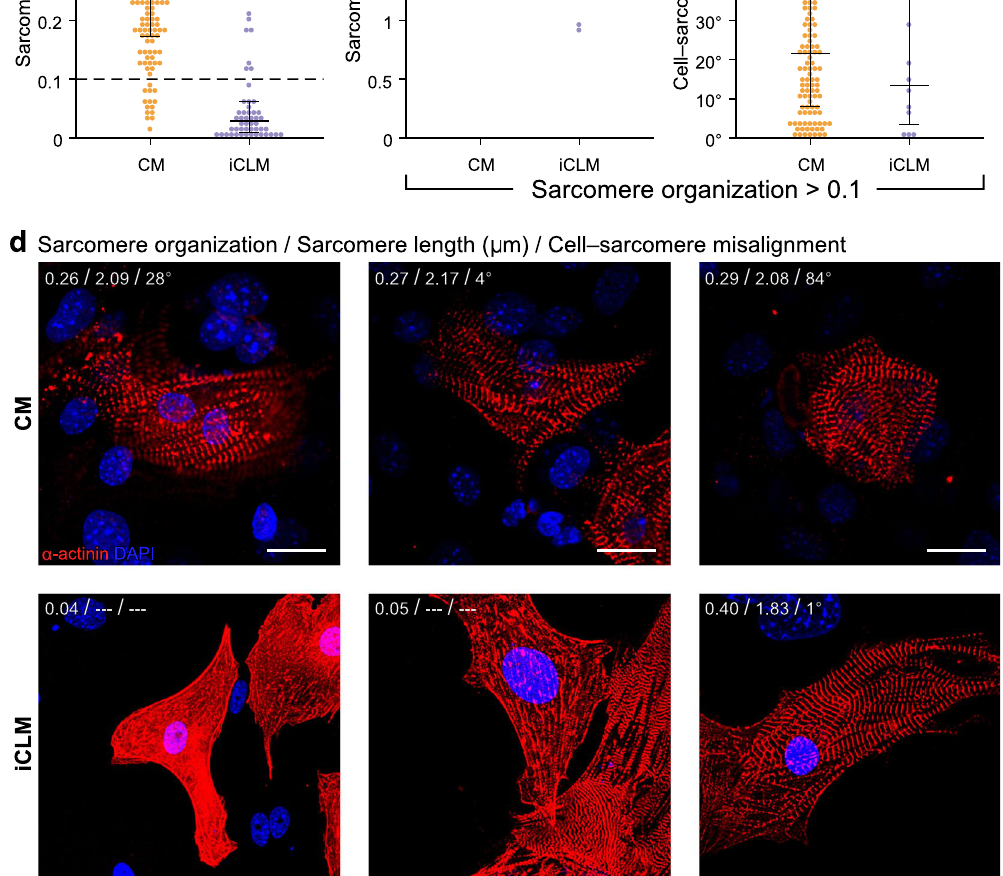
Figure 6. Sarcomere analysis of reprogrammed cardiomyocytes suggests an immature phenotype. ( a ) Sarcomere organization as calculated by Haralick correlation between neonatal mouse cardiomyocytes (CM) and fibroblast-reprogrammed induced cardiac-like myocytes (iCLM). Black bars represent 25 th , 50 th , and 75 th percentile. Only cells with sarcomere organization > 0.1 were analyzed for ( b ) sarcomere length and ( c ) cell– sarcomere misalignment. ( d ) Example images of sarcomere metrics in CMs and iCLMs. Sarcomere length and cell–sarcomere misalignment were not reported if sarcomere organization score was below the 0.1 threshold. Scale bar = 20 μ